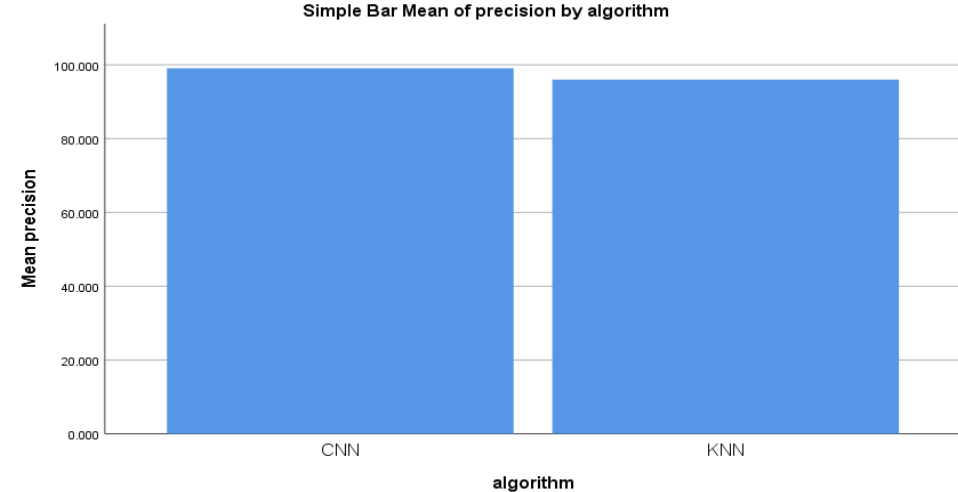
Figure 6. Precision mean for the CNN and KNN algorithms’ performance measure.